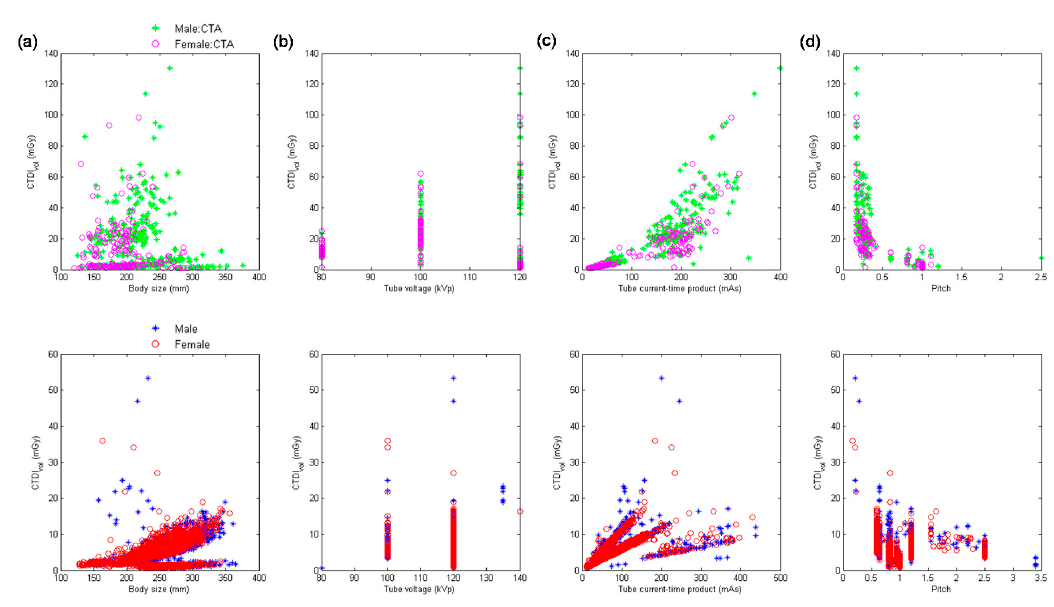
Figure 5. Scatter plots of CTDI vol versus ( a ) body size, ( b ) kVp, ( c ) mAs, and ( d ) pitch for chest CTA scans ( upper row) and chest scans excluding CTA ( lower row) performed using MDCT H . Table 8. Results of multivariate analysis for the chest scans performed using MDCT H . Predictor